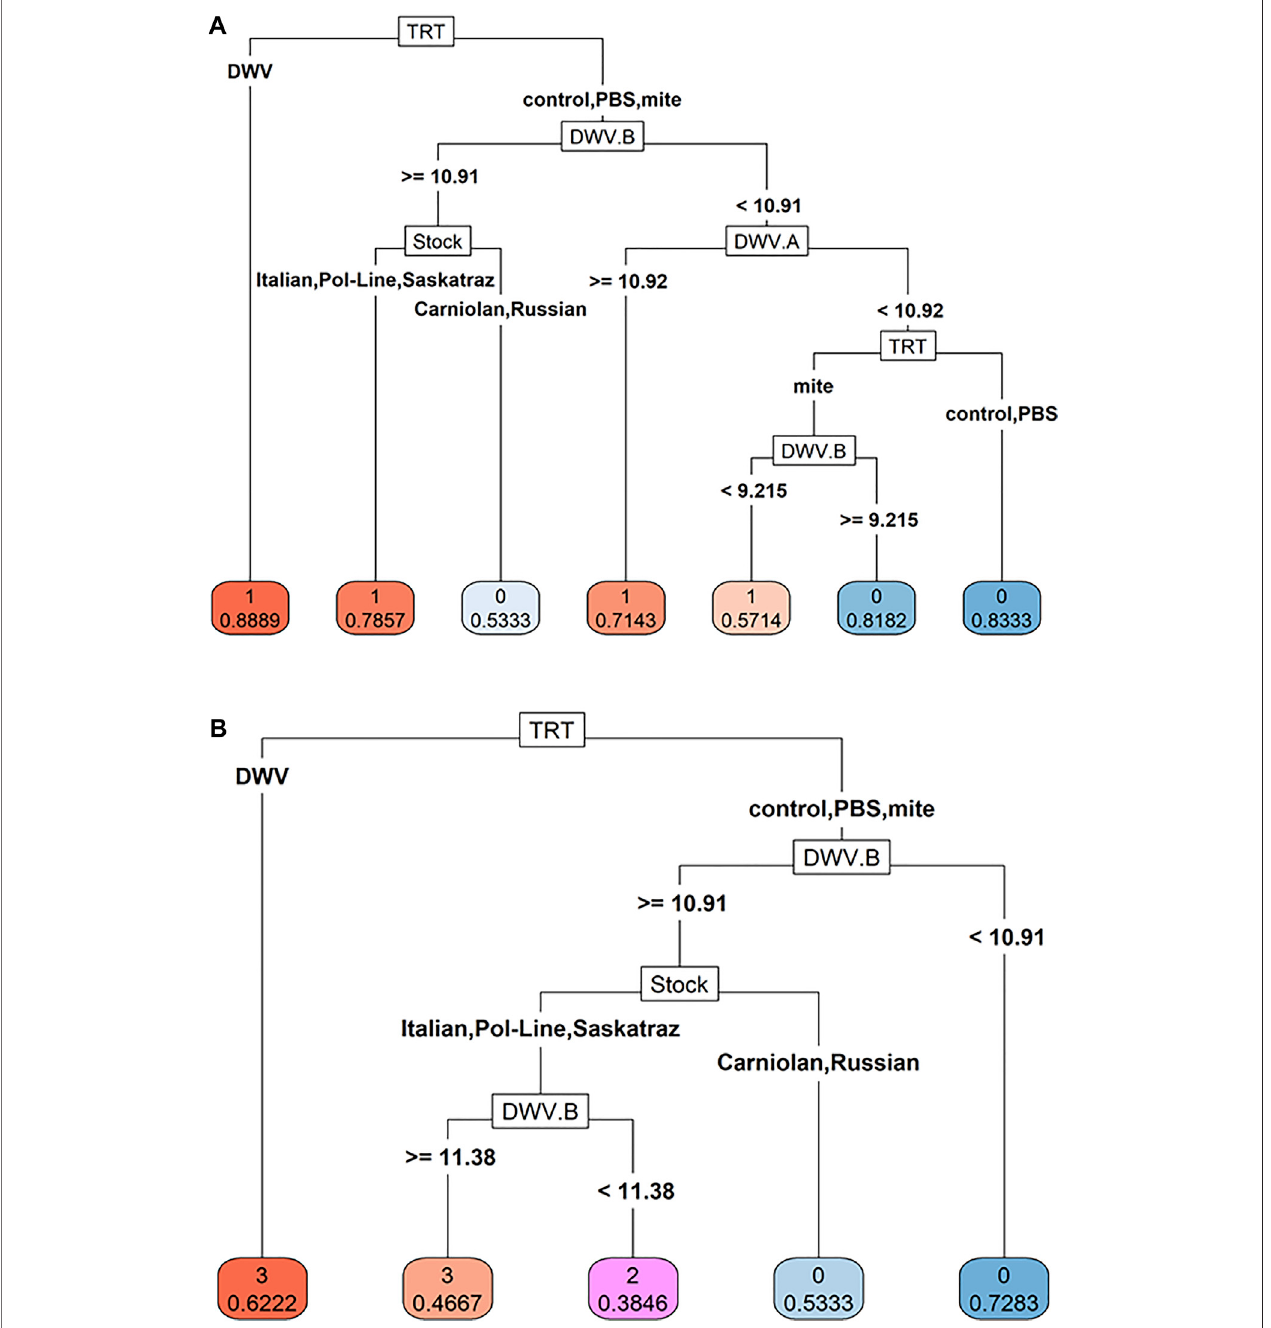
FIGURE7| Classi fi cationtreesofDWVsymptoms.Classi fi cationtreestoanalyze (A) DWVsymptompresence(presence=1,absence=0)and (B) DWVsymptom severity (ordinal scale 0 – 3, 0 represents no symptoms, and 3 represents debilitating symptoms) were created using bee stock, treatment, log-transformed DWV-A (DWV.A) and DWV-B (DWV.B) levels as predictor variables through recursive partitioning and with a complexity parameter of > 0.01 after pruning. The predicted probabilities per decision node are shown beneath each variable categorization (i.e., 0 = asymptomatic, 1 = symptomatic in A; or the scale of 0 – 3 where 0 representsnosymptomsand3representsdebilitatingmorphologicalsymptomsbasedon SupplementaryFigureS1 ).Virusdatawerebasedonheadtissues(N=180 bees).